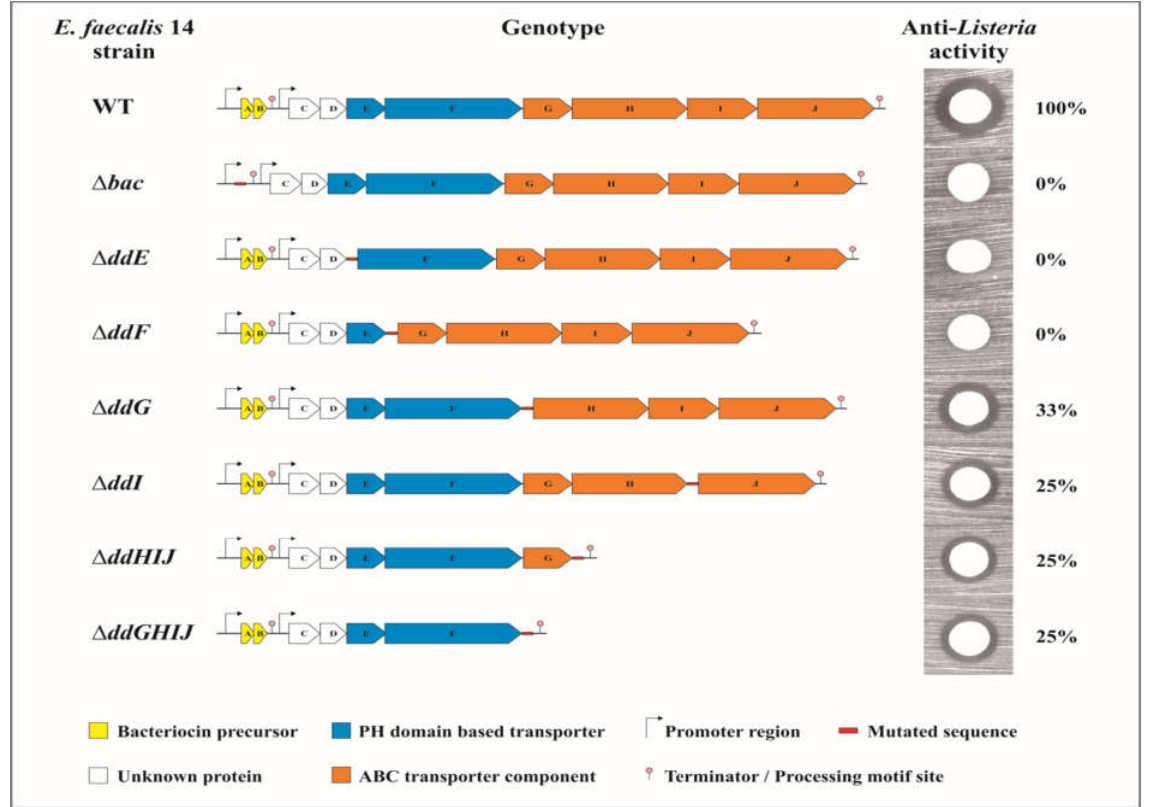
Figure 1. Schematic representation of Enterococcus faecalis 14 mutants showing their genotypes and their antibacterial activities against Listeria innocua ATCC 33090. A volume of 4 µL in an overnight culture ~2 × 10 9 CFU/mL was spotted on the Brain Heart Infusion plate. The data are the means of at least three independent experiments.